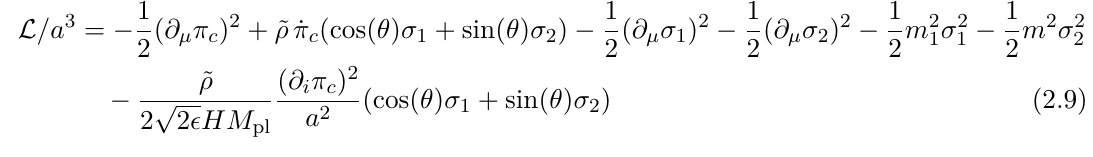
Figure 3 . Schematic representation of the different kinematical regimes of the bispectrum. Event 1 is the sound horizon crossing of the short mode k mode k L